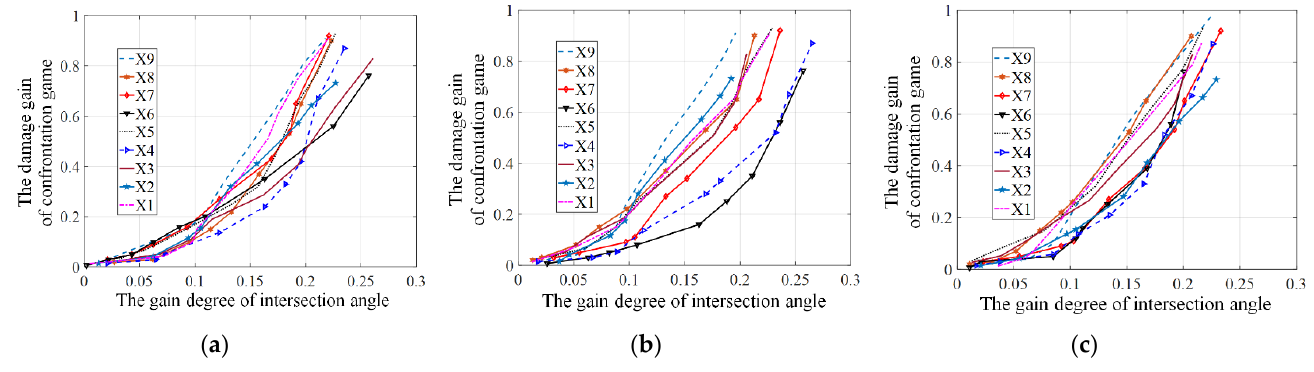
Figure 6. The damage gain of the confrontation game under the different intersection angles of the projectile and the target: ( a ) The damage gain of the confrontation game when the intersection angle of the projectile and the target is 30°; ( b ) The damage gain of the confrontation game when the intersection angle of the projectile and the target is 45°; ( c ) The damage gain of the confrontation game when the intersection angle of the projectile and target is 60°.